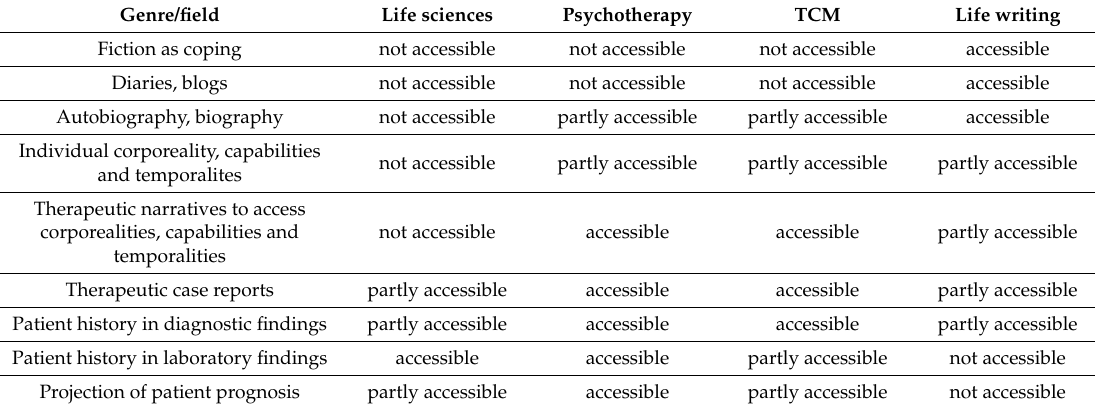
Figure 1. Liminal experiences in life as the basis of interdisciplinary research between different academic disciplines in life sciences and life writing. Table 1. Transdisciplinary perspectives on narrative concepts of PTSD to avoid “blind spots”.